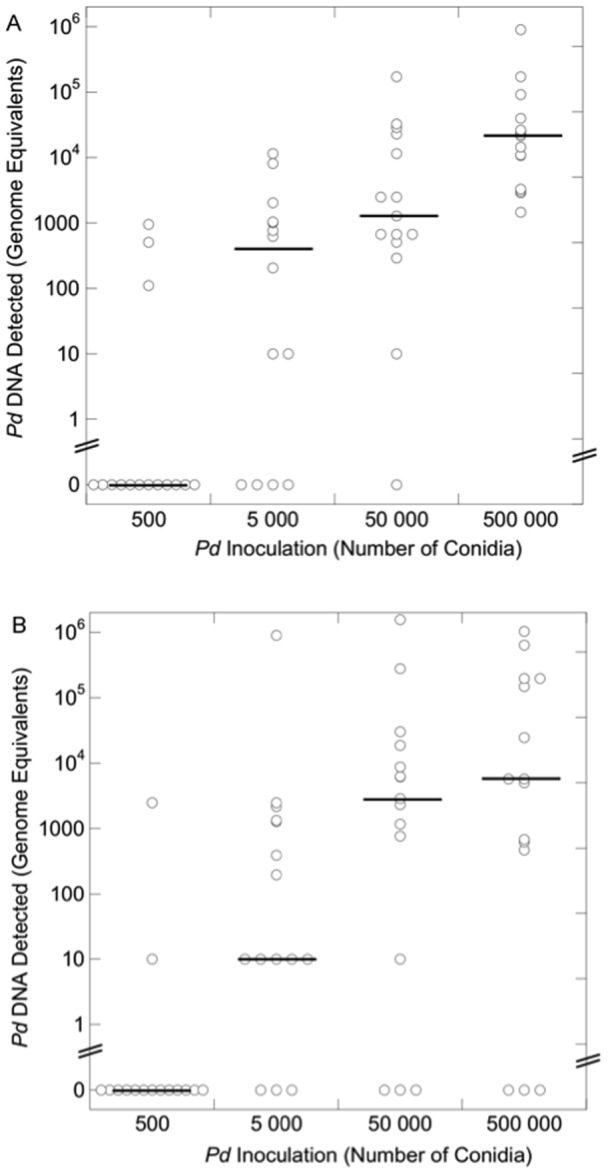

Pseudogymnoascus destructans (Pd) DNA detected at the end of hibernation on little brown myotis (Myotis lucifugus) inoculated with varying doses of Pd conidia and hibernated for five months at either 4°C (A) or 10°C (B).Individual observations are represented with open circles and medians represented by horizontal lines. At both temperatures, significantly less Pd was detected on bats in the 500 conidia group than on bats in other treatment groups. At 4°C, less Pd was detected on bats inoculated with 5 000 conidia compared to bats inoculated with 500 000.